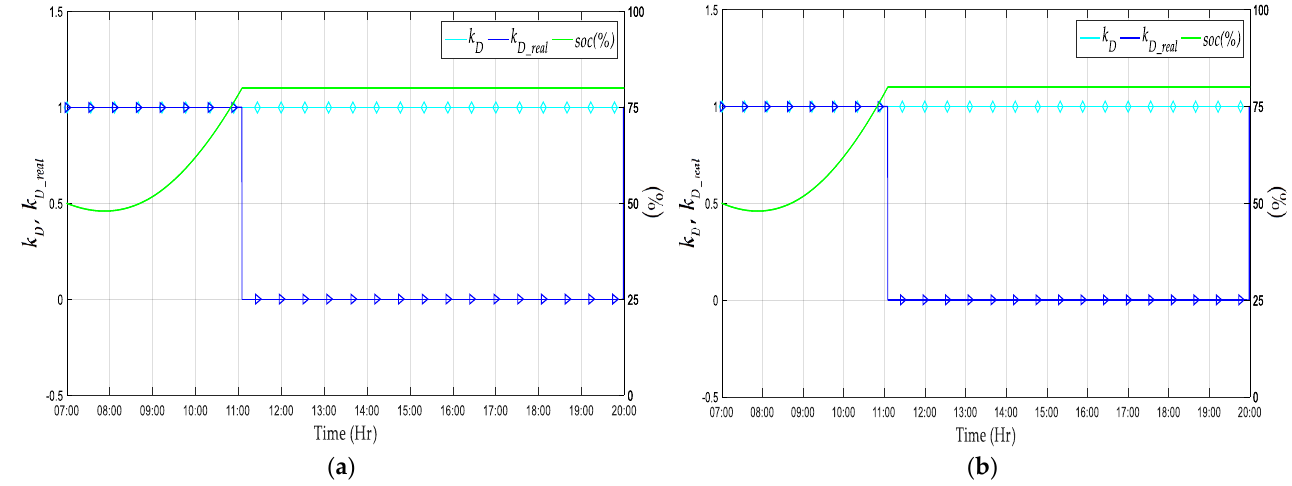
k , Figure 8. Evolution of k , and soc without optimization by applying the  coefficient in Figure 8. Evolution of k D , k D _ real and soc without optimization by applying the γ coefficient in the D _ D real the case of: ( a ) case of: ( a ) c PVS > c WDS ; ( b ) c PVS < c WDS